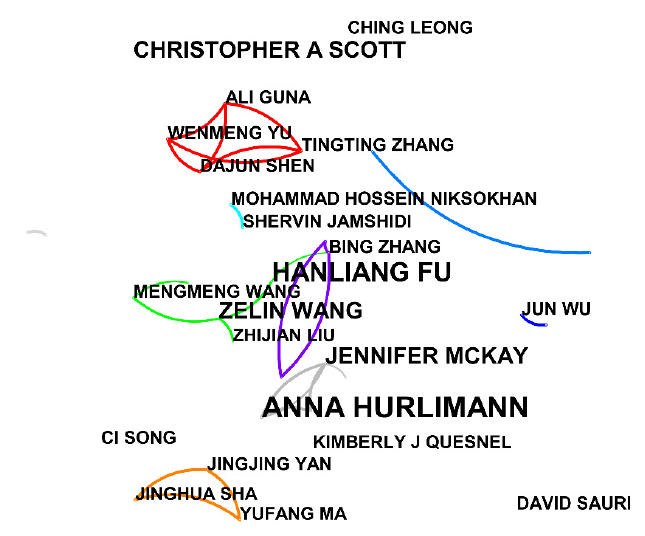
Figure 5. Collaboration chart of international authors.